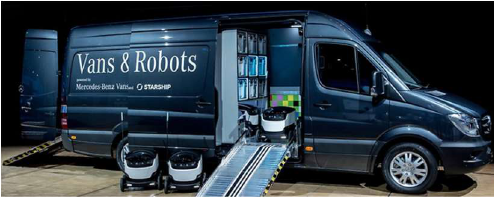
Figure 1. Truck-based autonomous robots [6]